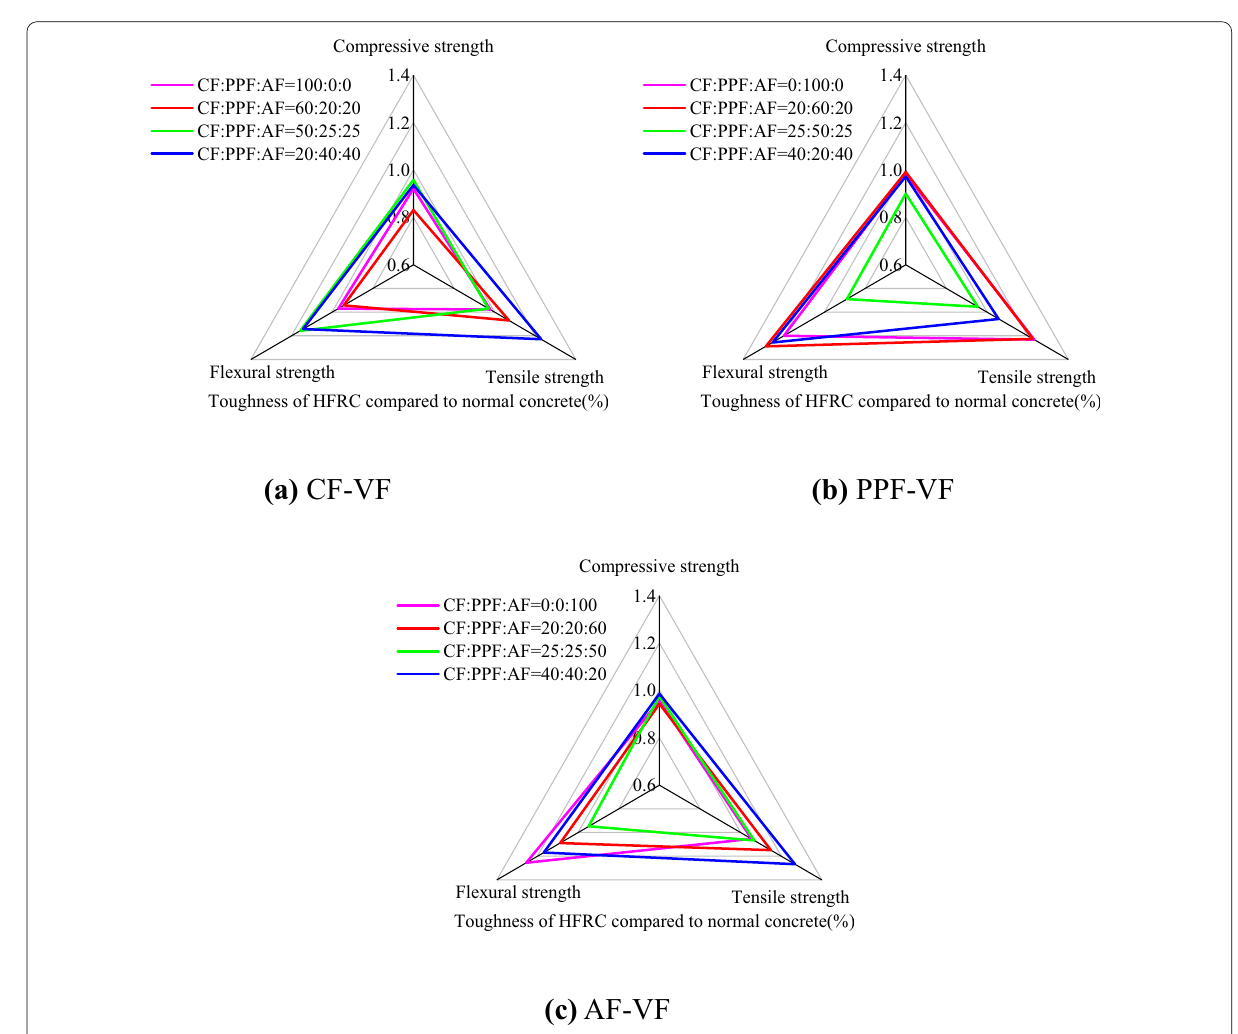
Fig.8 Mechanical properties based on cube specimens. a CF-VF. b PPF-VF. c